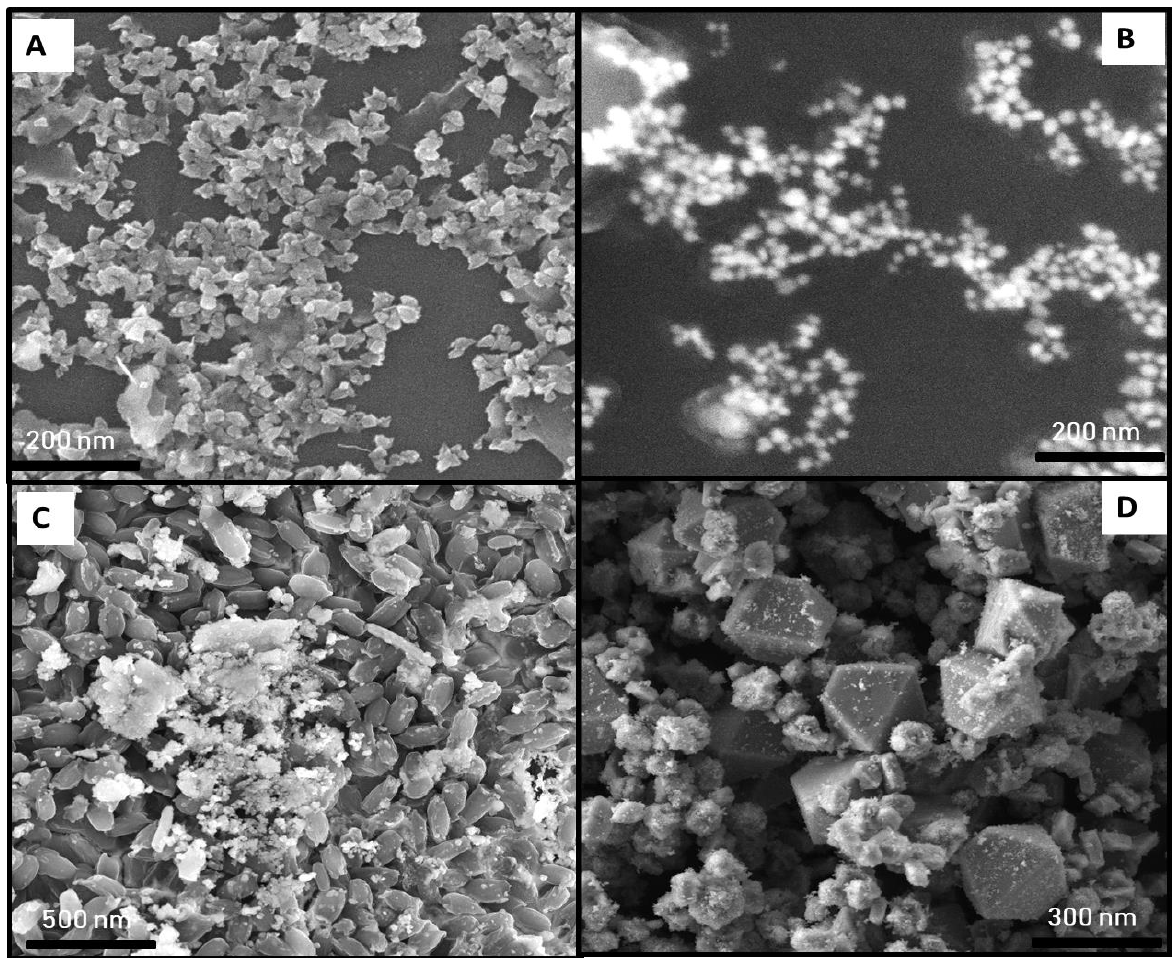
Figure 7. SEM images of monometallic NPs. ( A ) Control AgNPs. ( B ) UV-C mediated AgNPs. ( C ) Control ZnONPs. ( D ) UV-C mediated ZnONPs.